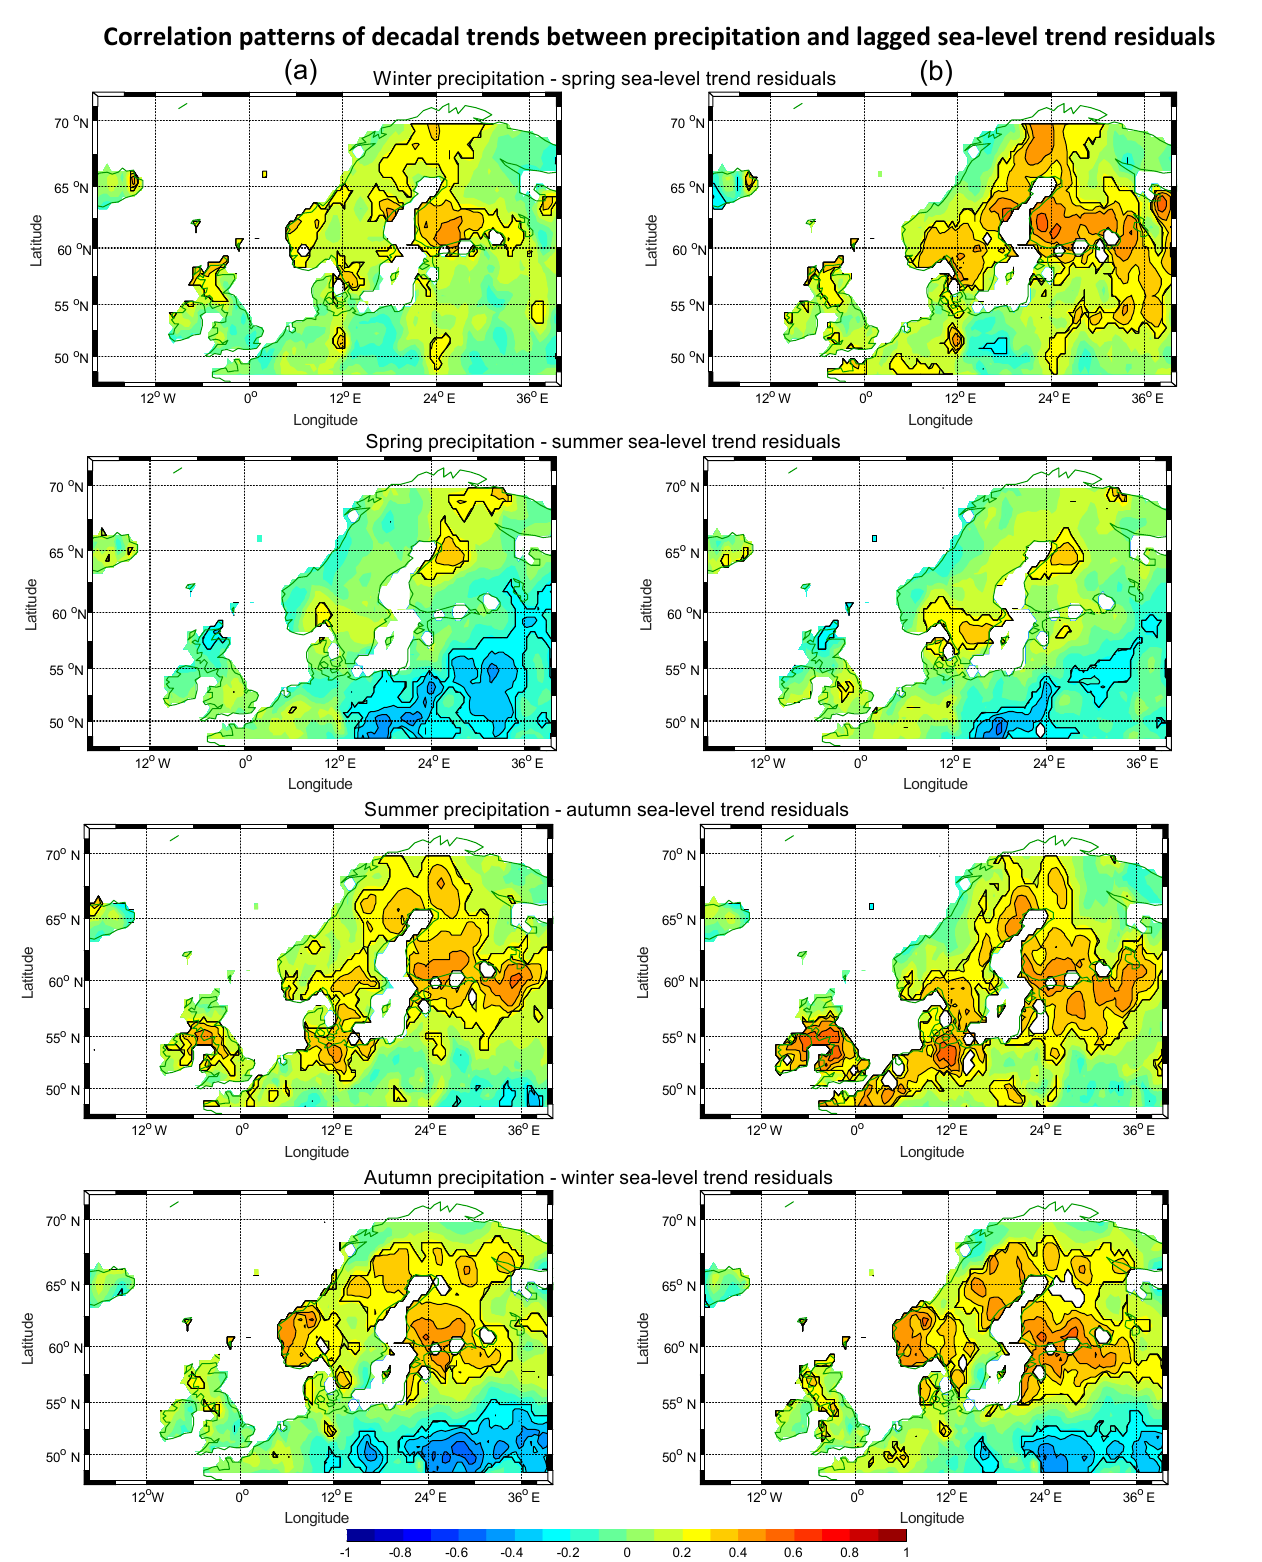
Figure 8. The correlation patterns between the decadal sea-level trend residuals and the area-averaged CRU precipitation decadal trends in the previous season over the Baltic Sea catchment area for the period 1900–2012. Panels (a) and (b) show the results of Stockholm (Warnemünde) station. The areas indicating significant correlations are delineated with contour